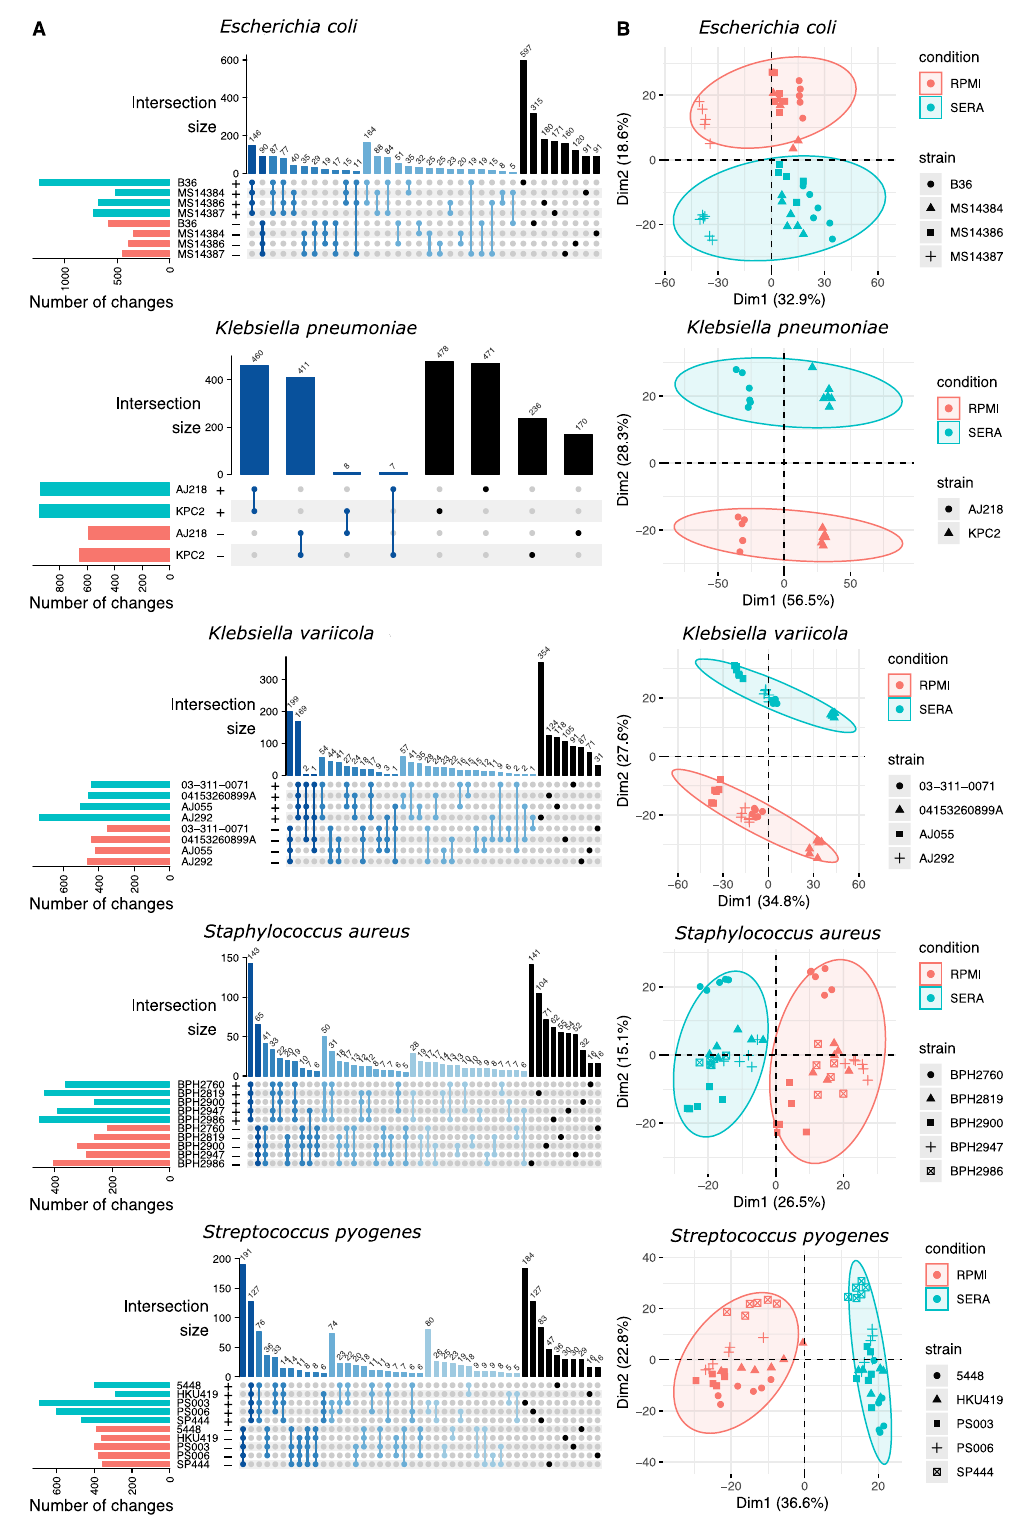
Fig.4|RNA-seqtoassessglobalserumexposureimpactsonthetranscriptome. A UpSet plot representing the shared and distinctive transcriptional responses across strains of the same species. Only genes with signi fi cant differential expres- sion after exposure to human serum are represented (FDR<0.05; |log 2 fold change|>1). Horizontal bars indicate the total number of signi fi cant changes per strain (top: up in serum, bottom: down in serum). Vertical bars represent the number of shared up/down genes across strains. Overlapping responses